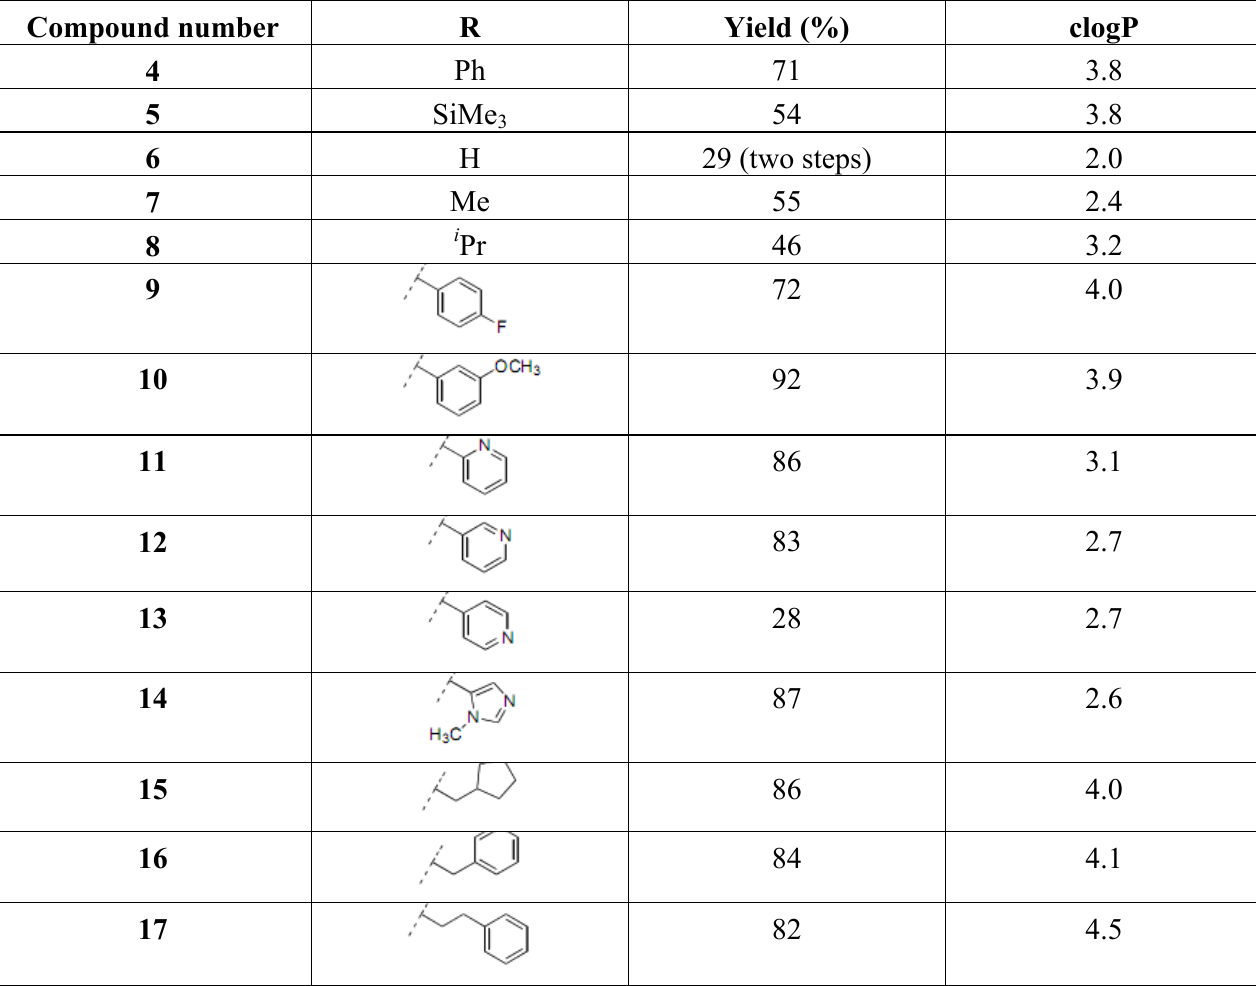
Table 1. Tetrazoles 4-16